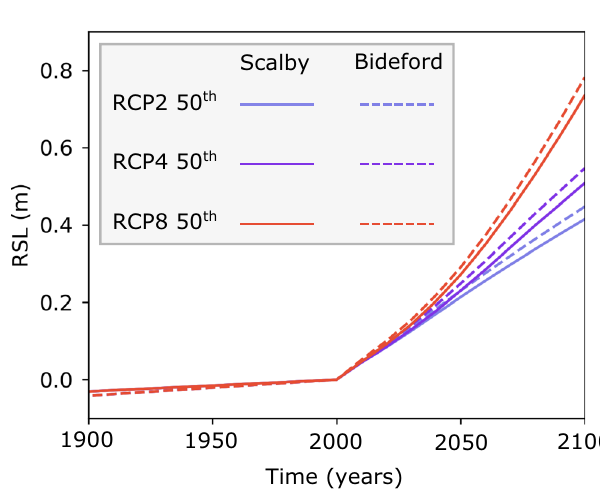
Fig.3|RelativeSealevel(RSL)fortheyears1900 – 2100forBidefordandScalby. Representative Concentration Pathways RCP2, RCP4 and RCP8 50th SLR projec-